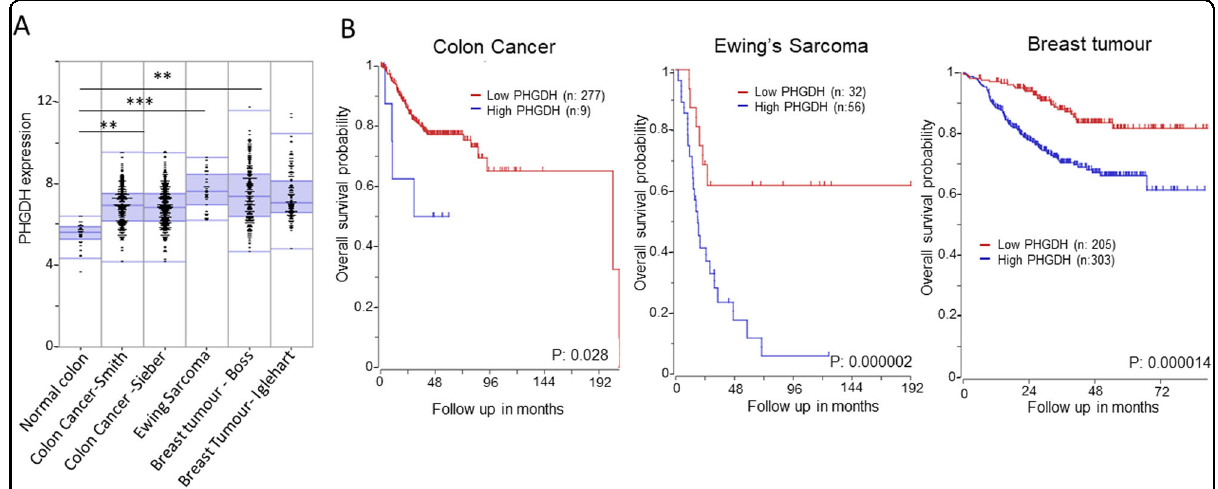
Fig. 2 PHGDH expression is a poor prognostic marker for colon cancer, Ewing ’ s sarcoma and breast tumours. A Analysis of PHGDH expression levels in normal colon (32 patients-Marra), colon cancer (232 and 290 patients-Sieber), Ewing ’ s Sarcoma (37 patients-Francesconi) and breast tumours (204 and 123 patients-Bos). (** P :0.0025; *** P :0.0001) B Kaplan-Meier survival curve based on high and low PHGDH expression levels in colon cancer, Ewing ’ s sarcoma and breast tumours derived from SieverSmith, Savola and Booser cohort with 355, 117 and 508 patients, respectively. Tumours with high PHGDH expression showed decreased survival. Data were acquired from the R2:GenomicsAnalysisandVisualizationPlatform and signi fi cance is calculated with a one-way ANOVA between